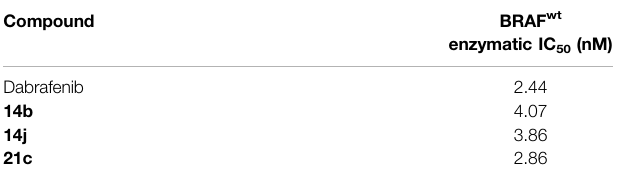
TABLE 2 | Enzymatic activity of dabrafenib, 14b , 14j and 21c against wild-type BRAF